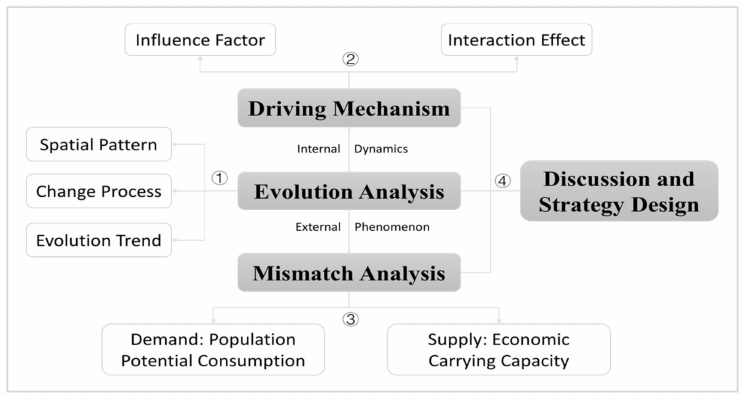
Figure 2. Research